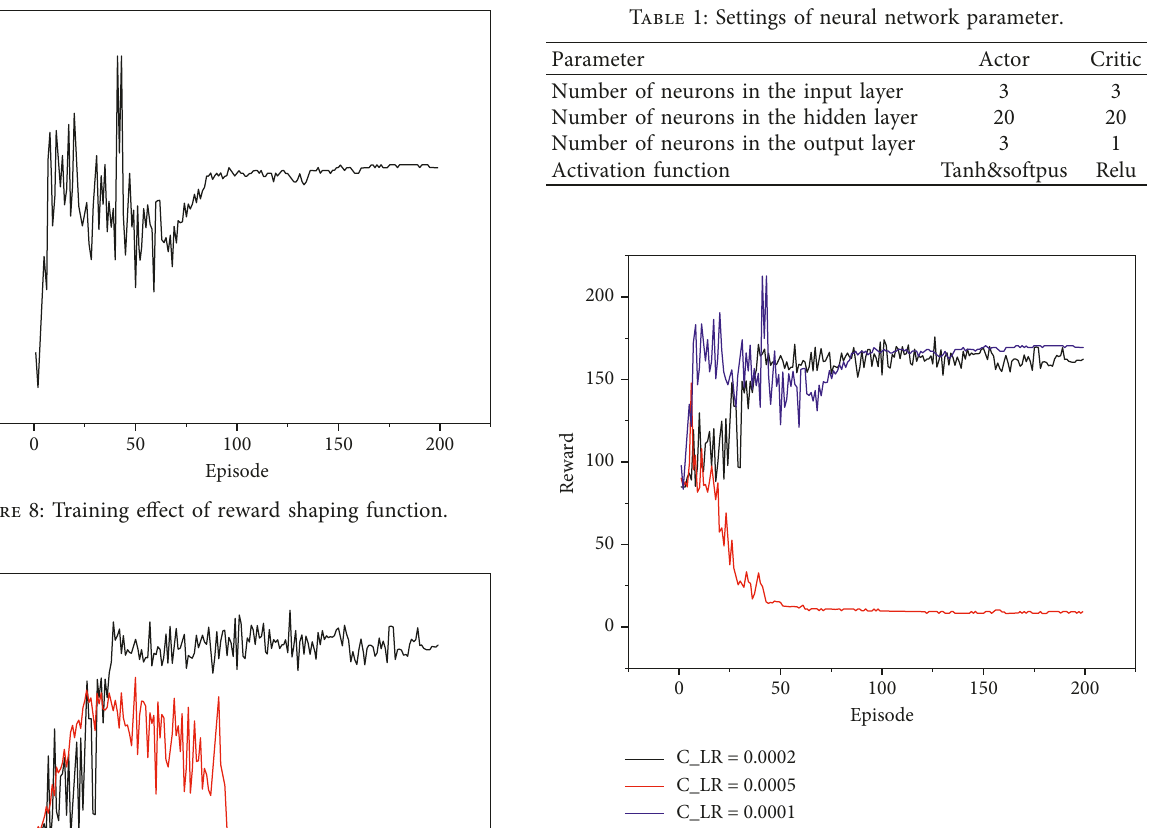
Figure 10: Training effects of critic with different learning